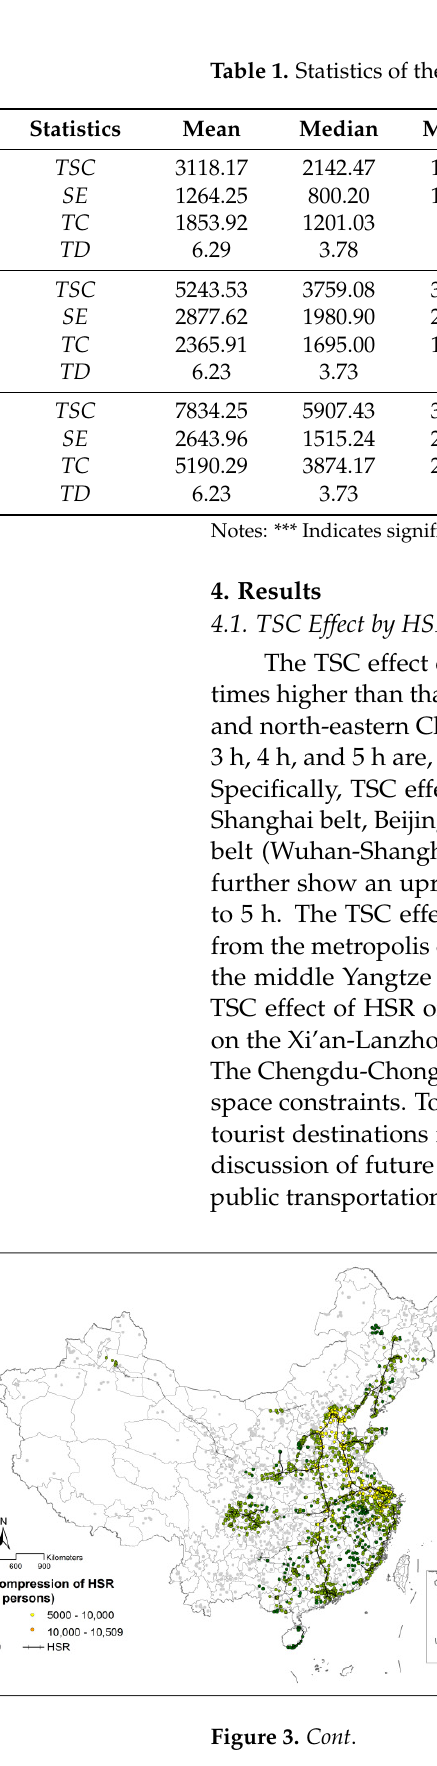
Figure 3. TSC effect of HSR on tourist destinations. ( A – C ) represent the TSC effect under temporal distance of 3 h, 4 h and 5 h respectively during 2008–2019. ( D ) shows the Violin Plot of TSC effect of HSR in four regions of China (5 h). The maximum market accessibility driven by TC effect of HSR under the temporal distance of 3 h, 4 h, and 5 h is, respectively, 5461, 7955, and 14,113 million people, while the maximum market accessibility driven by the SE effect of HSR under the temporal dis- tance of 3 h, 4 h, and 5 h is, respectively 8524, 13,810, and 14,150 million people (see Figures 4 and 5). Compared to pre-HSR era, market accessibility under short temporal distance (such as 3 h) has not increased significantly from the aspect of TC effect, in spite of rapid HSR development. However, when the temporal distance increases to 5 h, the TC effect of HSR in certain areas, such as Beijing-Shanghai belt and Shanghai-Fuzhou belt, similar to the SE effect of HSR, has fundamentally changed the market structure, by connecting many locations to a destination within a half-day distance.